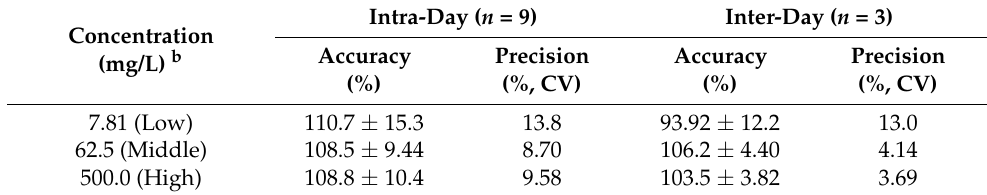
Figure 2. The elution of teicoplanin (A2-2) and IS (B2) with the optimized HPLC-UV method. ( A ) The chromatograms of ( a ) 100 mg/L teicoplanin solution without plasma, ( b ) 100 mg/L IS solution without plasma, and ( c ) teicoplanin and IS (each 50 mg/L) in human plasma. Numbers represented the indicated peak area. ( B ) The chromatograms of ( a’ ) human plasma only (blank), ( b’ ) teicoplanin (7.81 mg/L) and IS, and ( c’ ) teicoplanin (500.0 mg/L) and IS in the plasma. Black and grey arrows indicate A2-2 and the major forms (B2 and B1) of IS, respectively. Table 1. Intra- and inter-day accuracy and precision of teicoplanin (A2-2) with IS a